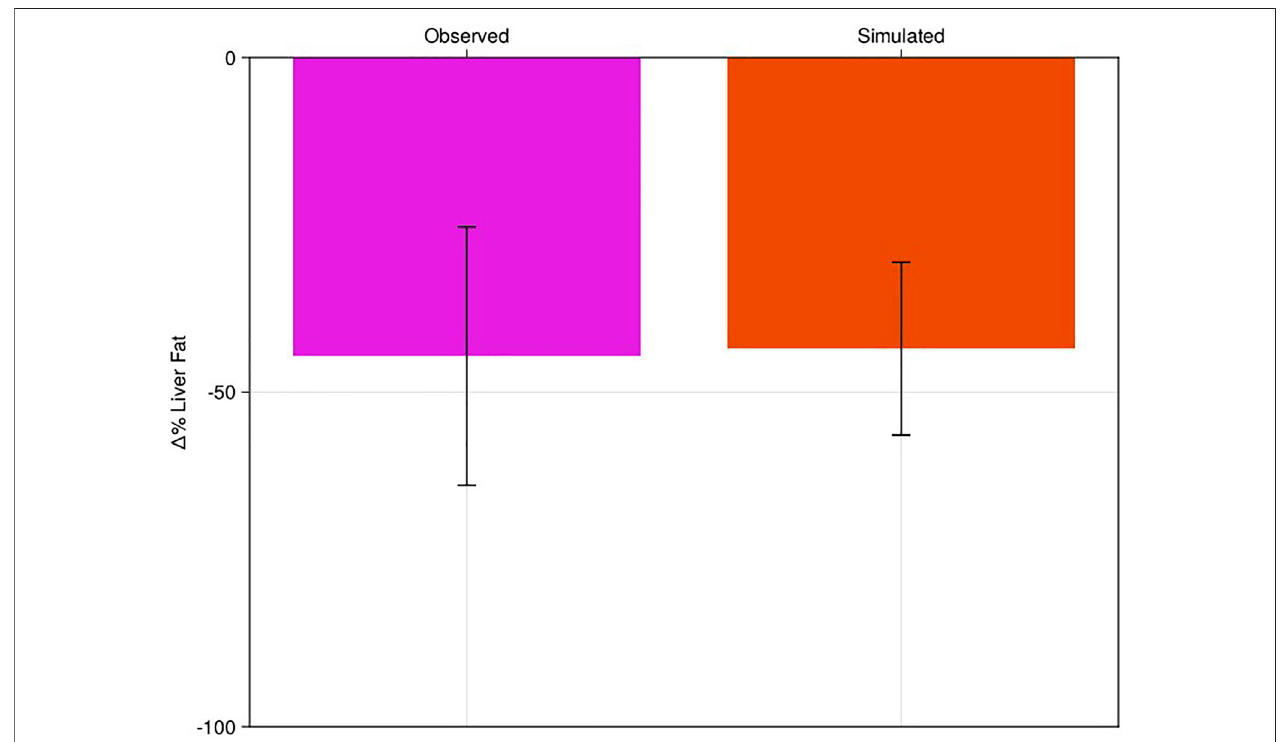
FIGURE4| Percentchangeofliverfatofvirtualpopulationtodiet-liketherapywithcomparisontoliterature.ClinicalresultsofHaufeetal.(pinkbar)comparedtothe NAFLD virtual patient response to dietary intervention (red). Bars are mean response of the cohort or virtual patients; error bars are estimated standard deviations.